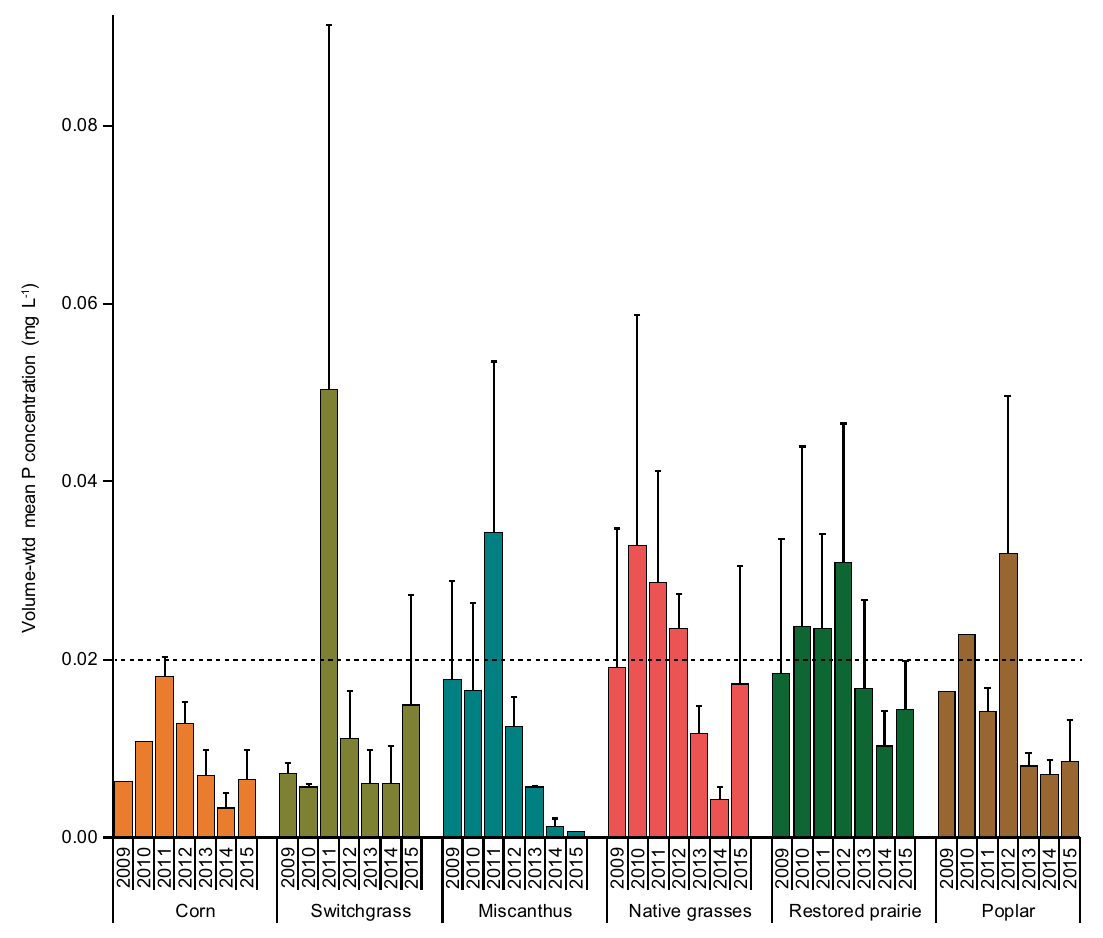
Figure 2. Volume-weighted mean concentrations (mg L −1 ) of total dissolved phosphorus in leachate from the different cropping systems collected with soil water samplers at ~ 1.2 m depth. Each bar shows the standard error of the mean of four replicate plots. In some crops during the 2009 and 2010 crop-years, data were available for only one or two plots. The cropping-system means grouped across years are not significantly different (p > 0.05) in pairwise comparisons as determined by the Tukey honest significant difference test. Dashed line